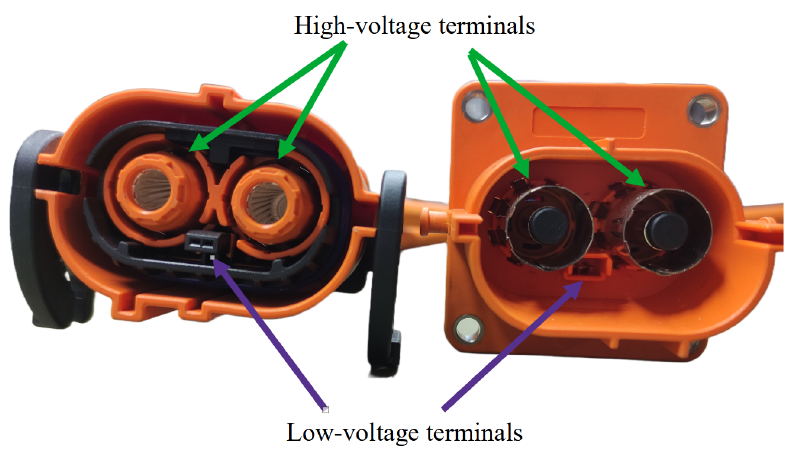
Figure 14. Power connectors with low-voltage